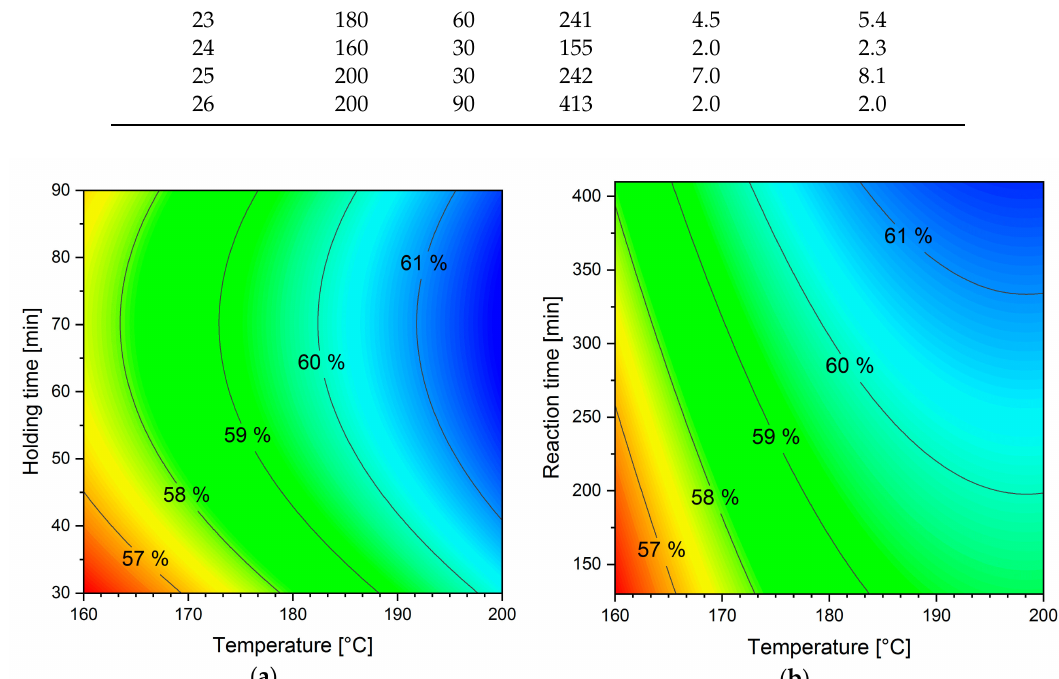
Figure A1. Regression model contour plots showing the dependence of carbon content (% daf ) on reaction temperature and ( a ) holding time and ( b ) reaction